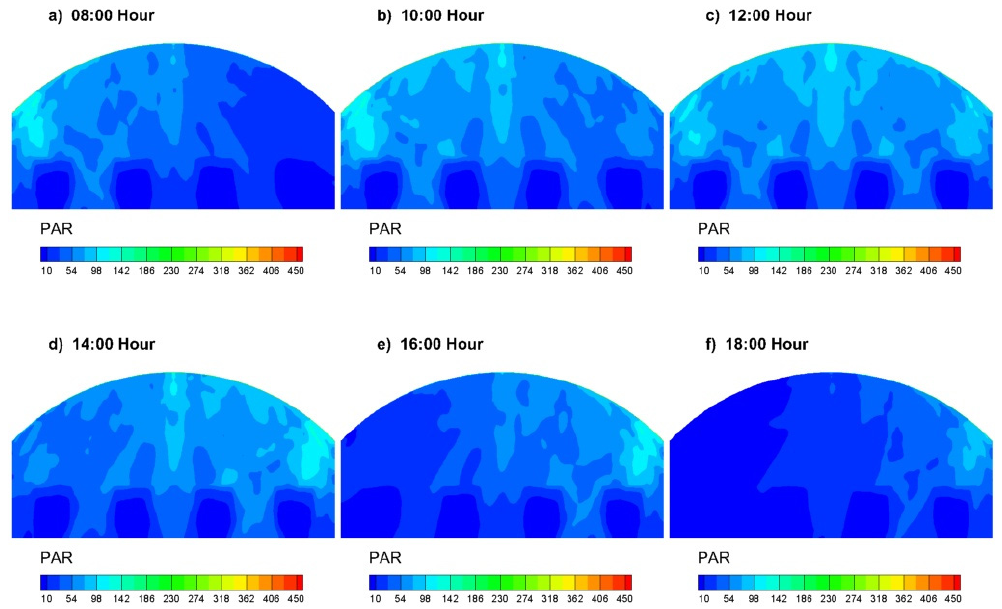
Figure 3. Photosynthetically active radiation (PAR) isocontours for 21 June and τ n,PAR = 30%.